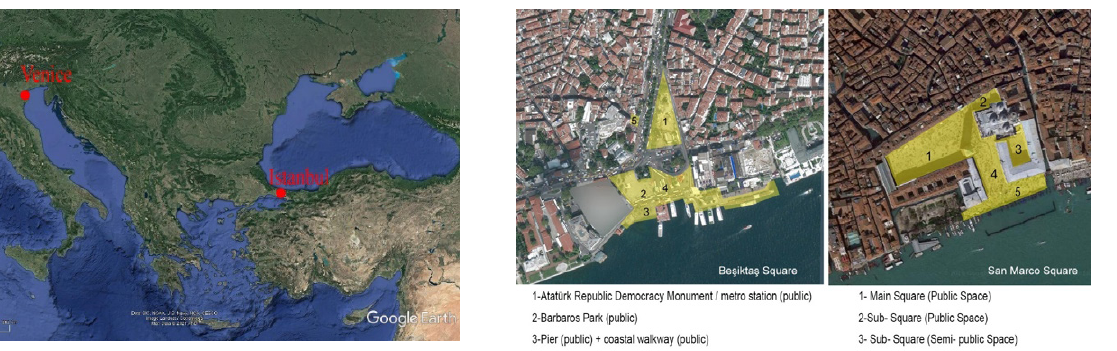
Figure 1. The map, showing Venice and Istanbul